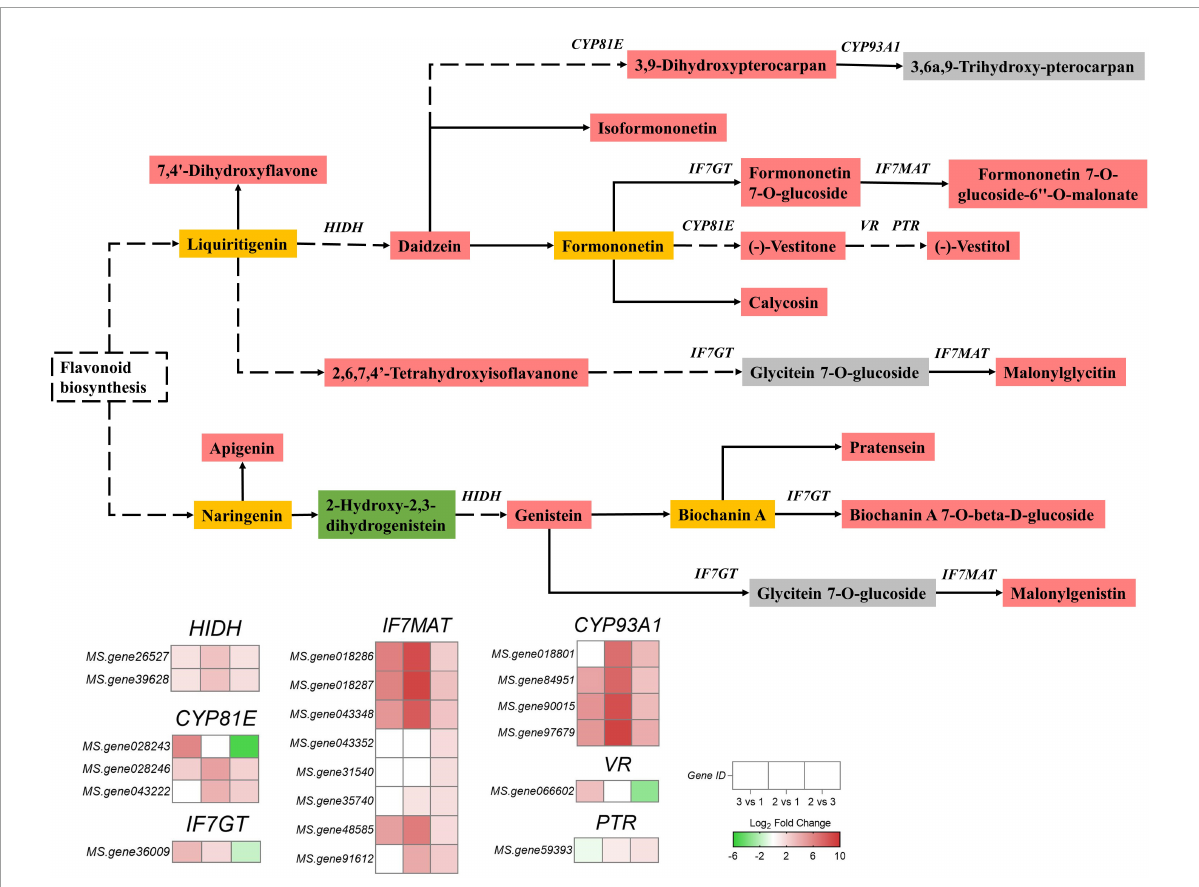
FIGURE5 Expression profiles of genes and metabolites involved in isoflavonoid biosynthesis of green vs. yellow alfalfa sprouts (2 vs. 3). The rectangle patterns of different colors represent metabolite accumulations in comparison 2 vs. 3: red indicates upregulated metabolites; green shows downregulated metabolites; yellow indicates that metabolites were detected, but there was no difference in their expression, and gray stands for metabolites that were undetected. The different colored squares indicate gene expression levels in comparisons 3 vs. 1, 2 vs. 1, and 2 vs. 3. Red and green represent up- and down-regulated genes,